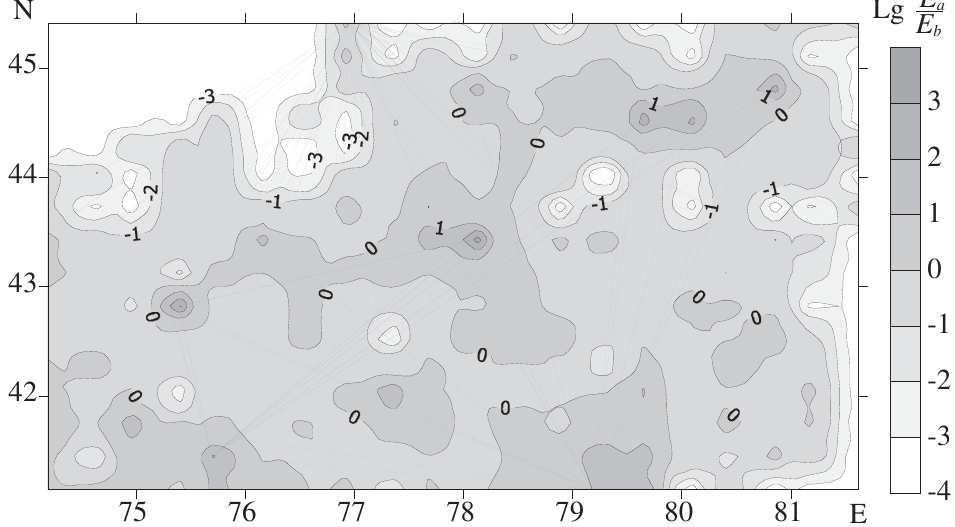
Fig. 3. Map of total seismic energy ratio of earthquakes in Northern Tien Shan area and adjacent territories for 20 days after and 20 days before MHD-generator